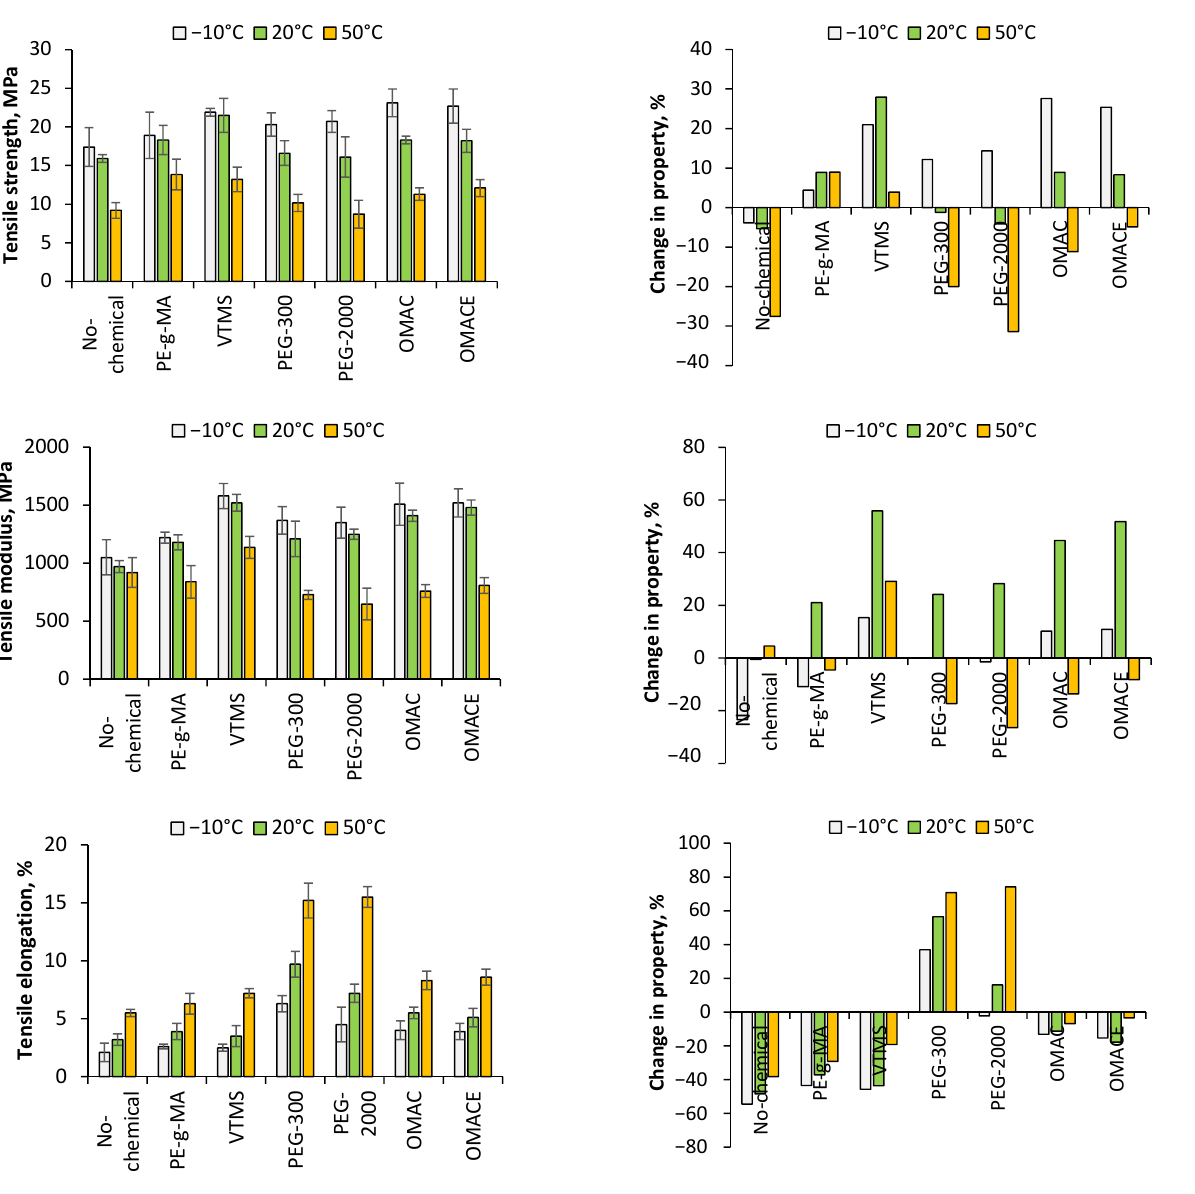
Figure 8. The tensile properties of nano ‐ cellulose reinforced PLA composites and the property change.